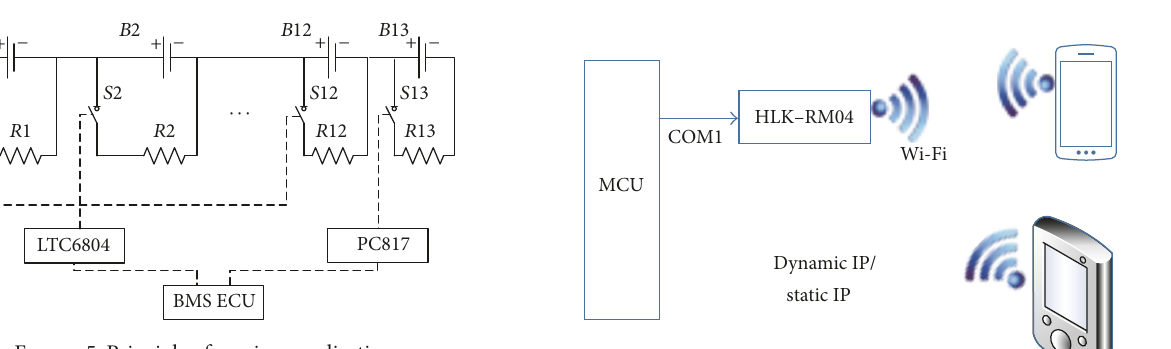
Figure 5: Principle of passive equalization.